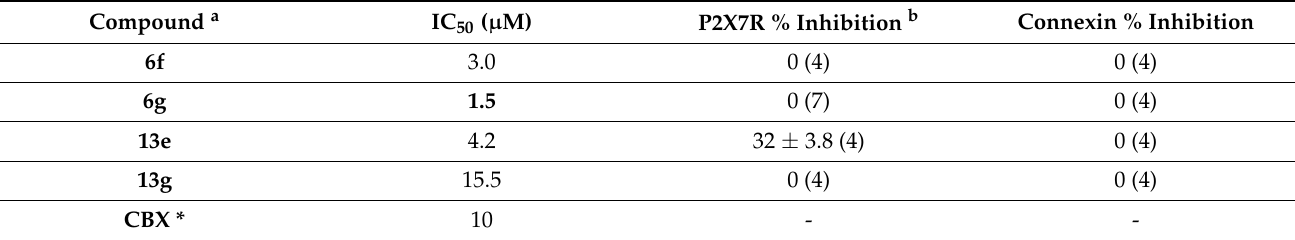
Table 3. IC 50 values and selectivity of 6f , 6g , 13e and 13g